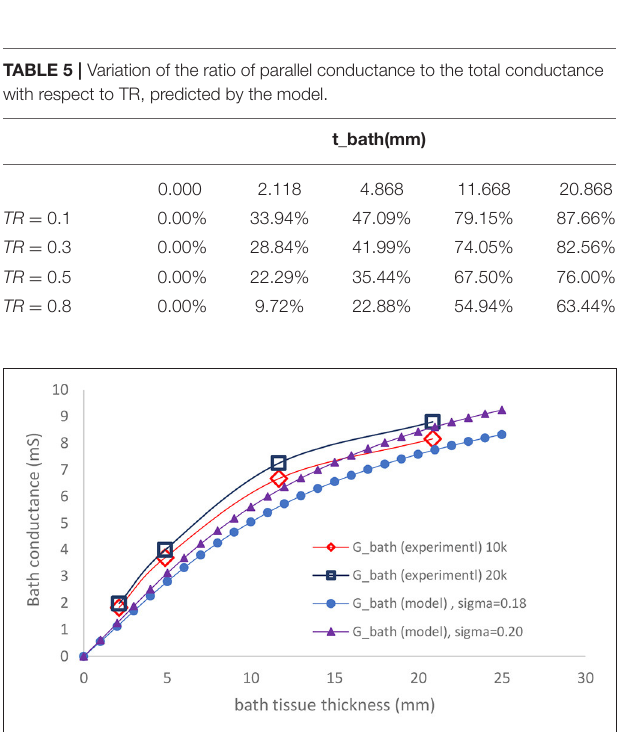
FIGURE 3 | Comparison of measured parallel conductance at 10 and 20KHz, with model prediction as function of bath thickness.